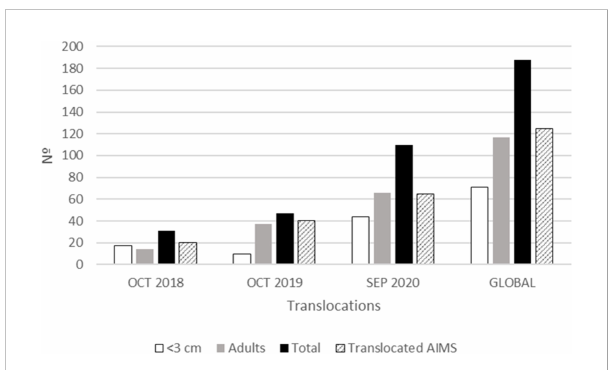
FIGURE 5 Number of individuals (juveniles, adults, and total) translocated per translocation event and at the end of the study (whole). The number of AIMS translocated is also shown.